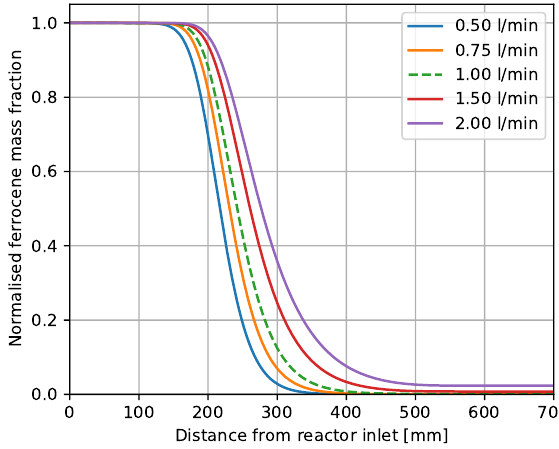
Figure 2. Plot of the simulation of the decomposition of ferrocene as a function of distance from the inlet, normalised by the ferrocene mass fraction at the inlet. Each line corresponds to different flowrates.